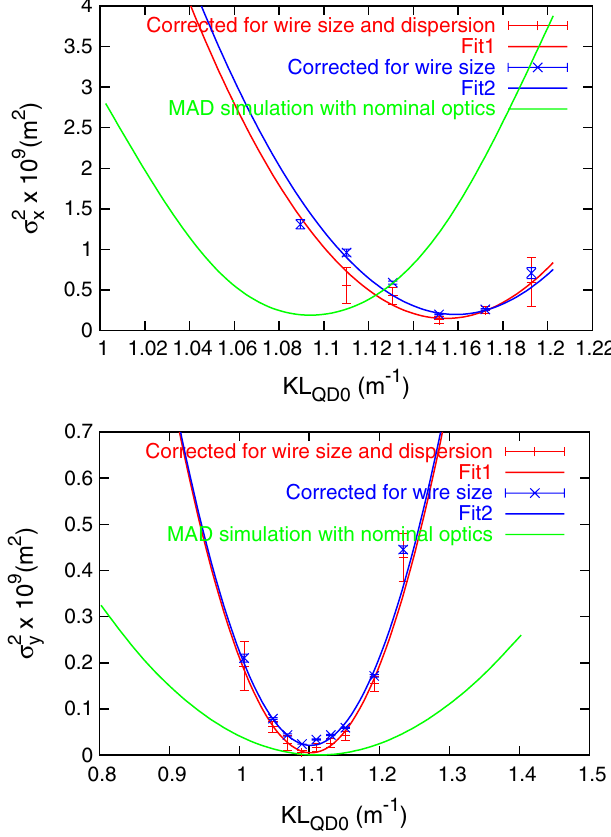
FIG. 6. Squares of horizontal and vertical beam sizes as a function of QD0 magnet strength on May 20 compared to the predictions from the optics simulation for the design large (cid:1) are the integrated QD0 magnet strengths, which optics. KL QD0 are computed from the power supply currents using relations based on the magnetic measurement data